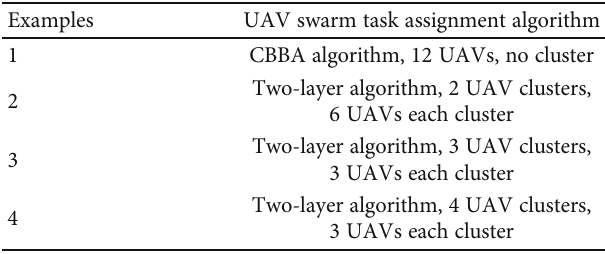
Table 9: Simulation examples.